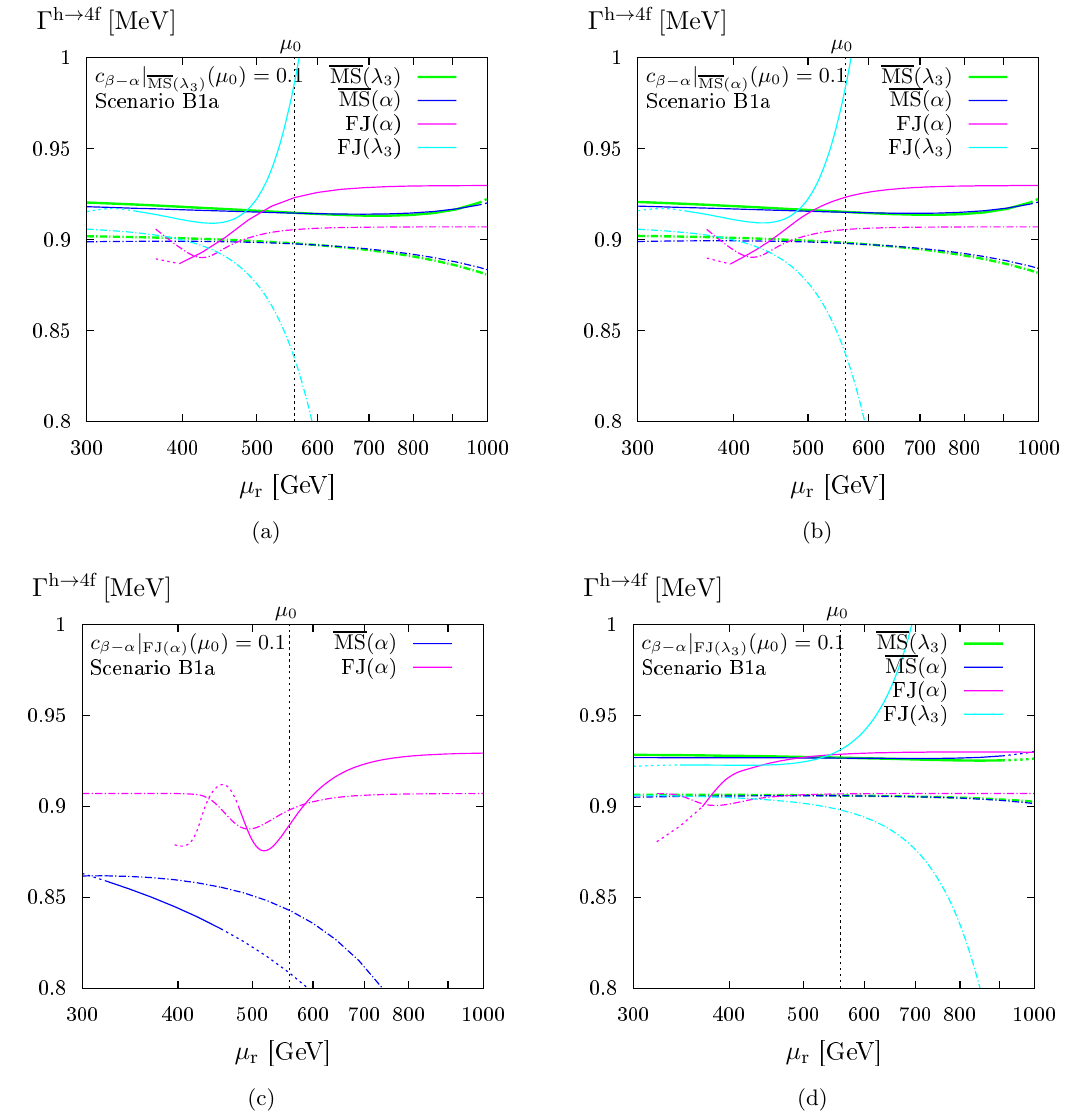
Figure 23 . The h 4 f width at LO (dashed) and NLO EW (solid) for scenario B1a in dependence ! of the renormalization scale. The panels (a), (b), (c), and (d) correspond to input values de(cid:12)ned in the MS( (cid:21) 3 ), MS( (cid:11) ), FJ( (cid:11) ), and FJ( (cid:21) 3 ) schemes, respectively. The result is computed in all four di(cid:11)erent renormalization schemes after converting the input at NLO (also for the LO curves) and displayed using the colour code of (cid:12)gure 9. The breakdown of perturbativity ( (cid:21) max indicated by changing the NLO curve to dotted lines. The dashed vertical line indicates the central renormalization scale (cid:22) r = (cid:22) 0